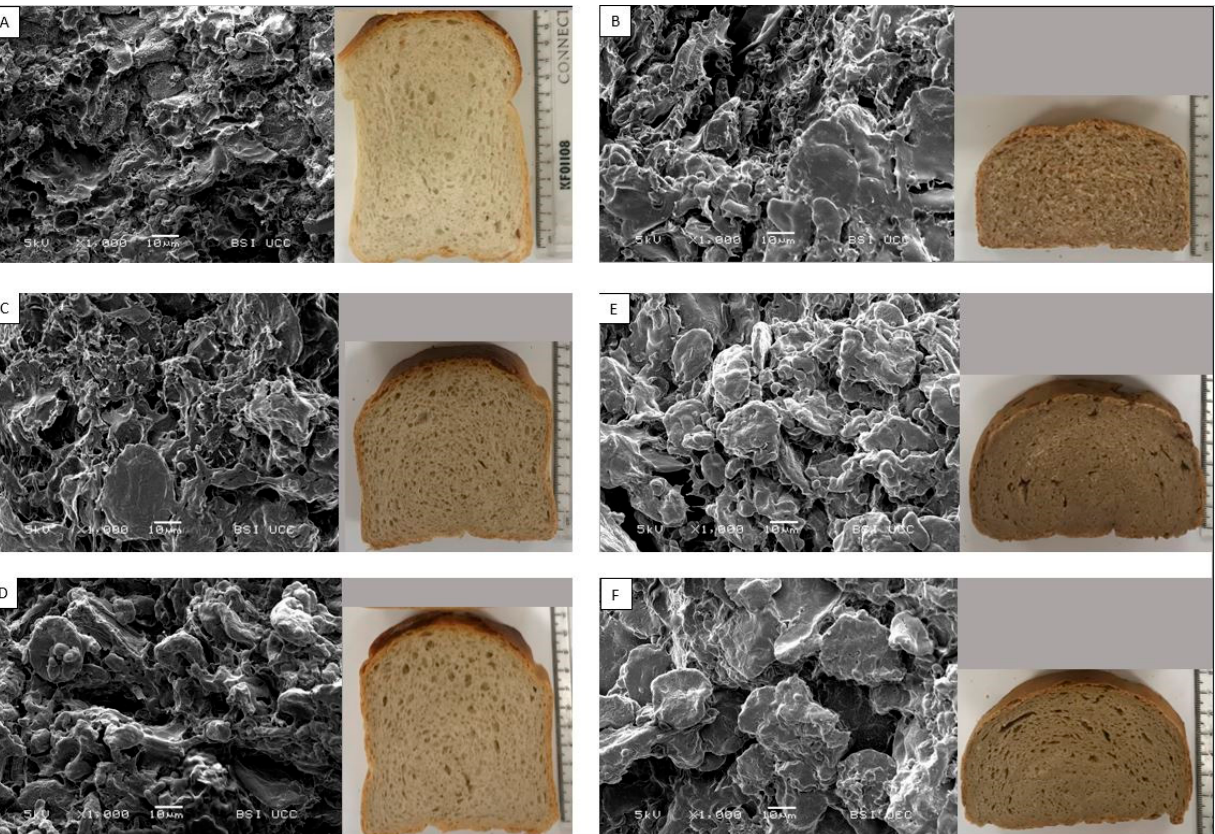
Figure 2. SEM micrographs of freeze-dried breads and images of their respective bread crumbs on day of baking. Pictures ( A – F ) illustrate baker’s flour ( A ), wholemeal flour ( B ), brewers’ spent grain “source of fibre” ( C ), fermented brewers’ spent grain “source of fibre” ( D ), brewers’ spent grain “high in fibre” ( E ) and fermented brewers’ spent grain “high in fibre” ( F )